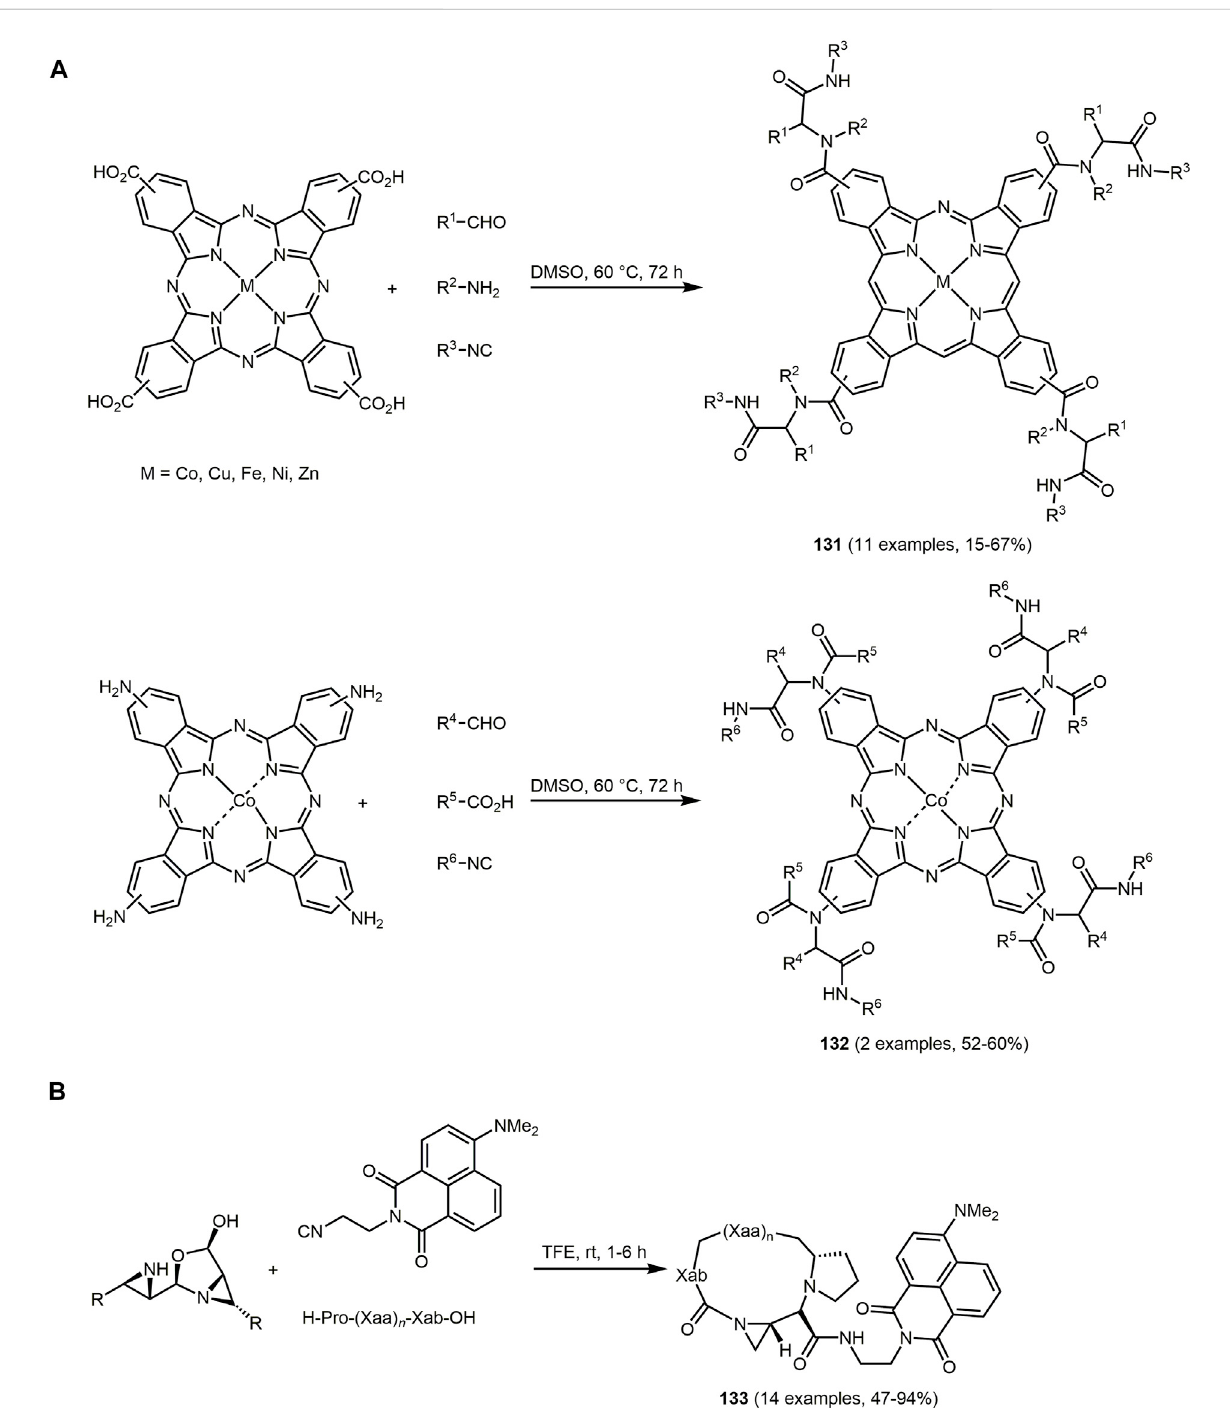
various porphyrin units of compound 130 act as decoupled supramolecular arrays. However, the steady state fl uorescence study shows emission quenching in presence of the Ru(II)- porphyrin units, presumably caused by strong spin-orbit